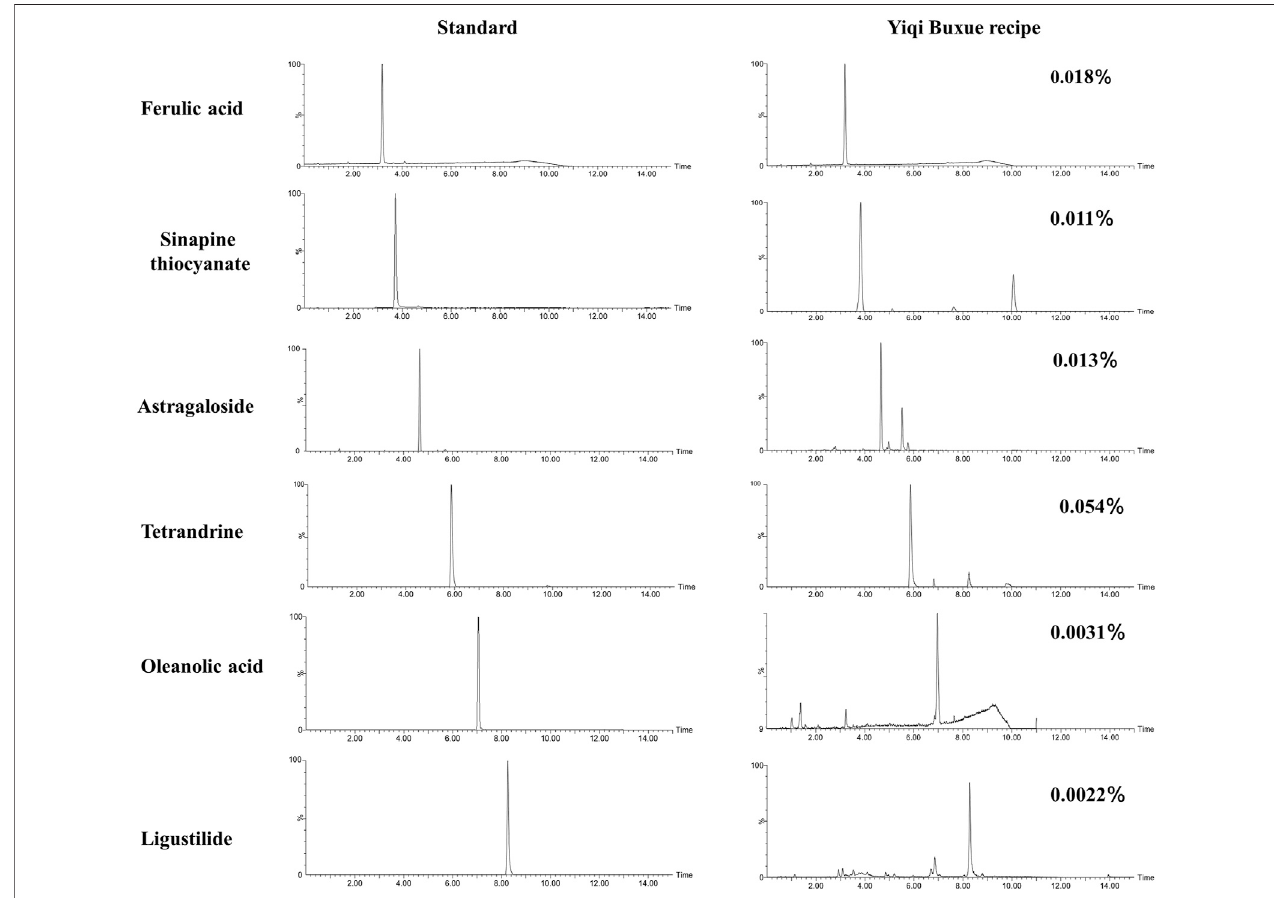
FIGURE 1 | Representative chromatograms and relative content of Ferulic acid (RT, 3.20 min, content of 0.018%), Sinapine thiocyanate (RT, 3.76 min, content of 0.011%), Astragaloside (RT, 4.65 min, content of 0.013%, Tetrandrine (RT, 4.65 min, content of 0.054%), Oleanolic acid (RT, 7.12 min, wavelength at 274 nm, content of 0.0031%) and Ligustilide (RT, 8.24 min, content of 0.0022%) in YQBXR analyzed by UPLC.